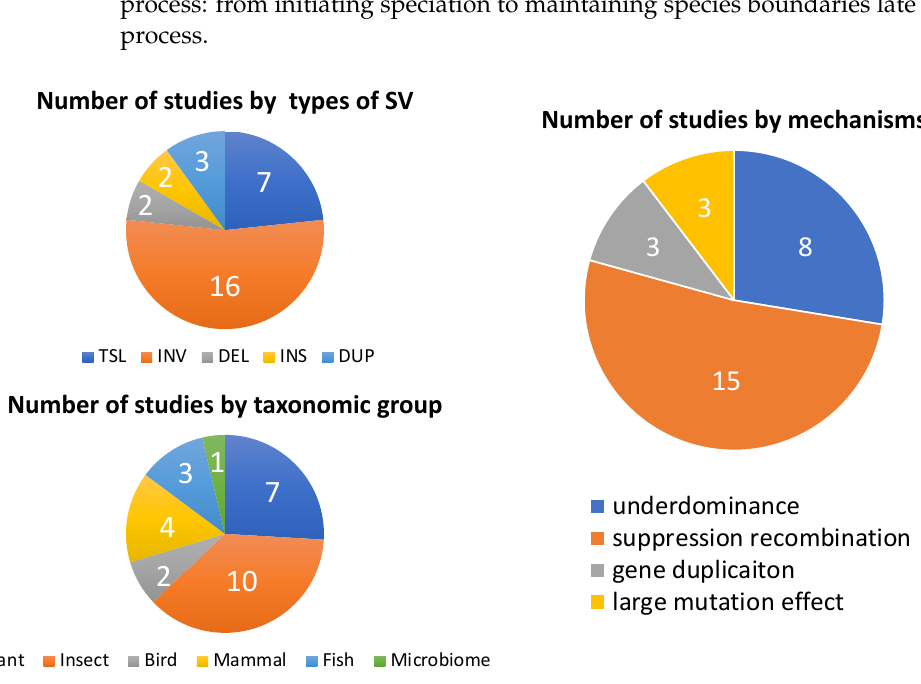
Figure 3. Summary of studies of structural variants involved in reproductive isolation. TSL, INV, DEL, INS and DUP stand for translocation, inversion, deletion, insertion and duplication,